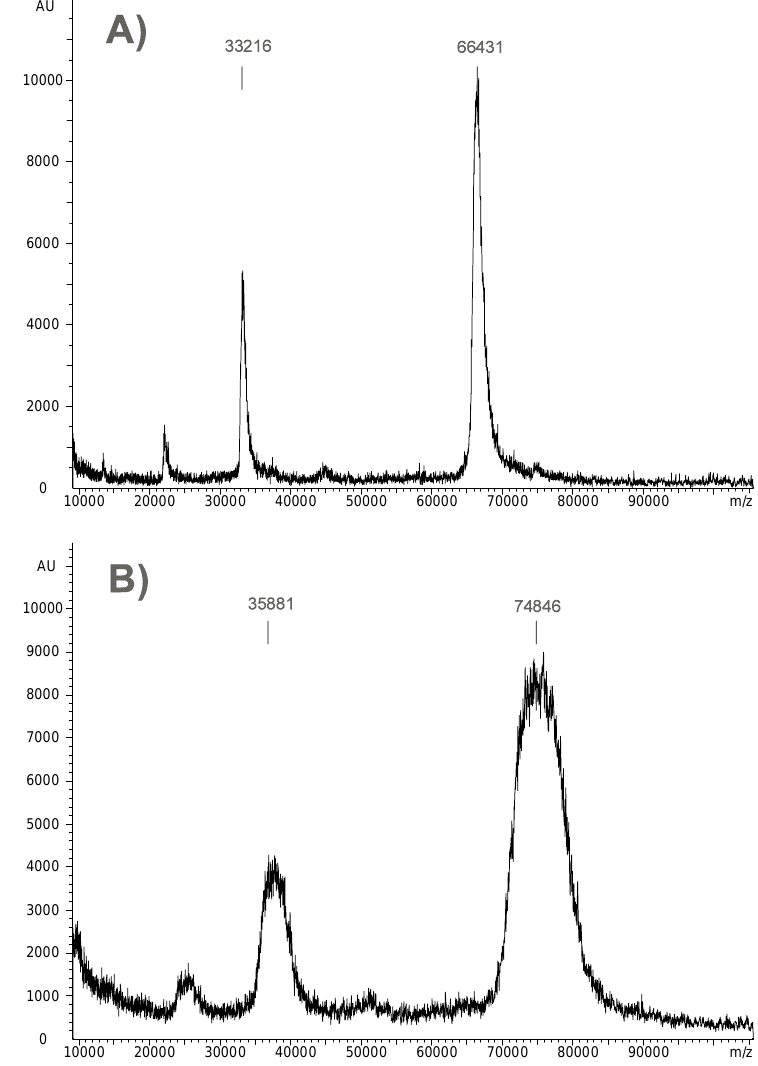
Figure 6. MALDI spectra of A) BSA and B) AFB2-GA-BSA showing [M+H] + and [M+2H] 2+